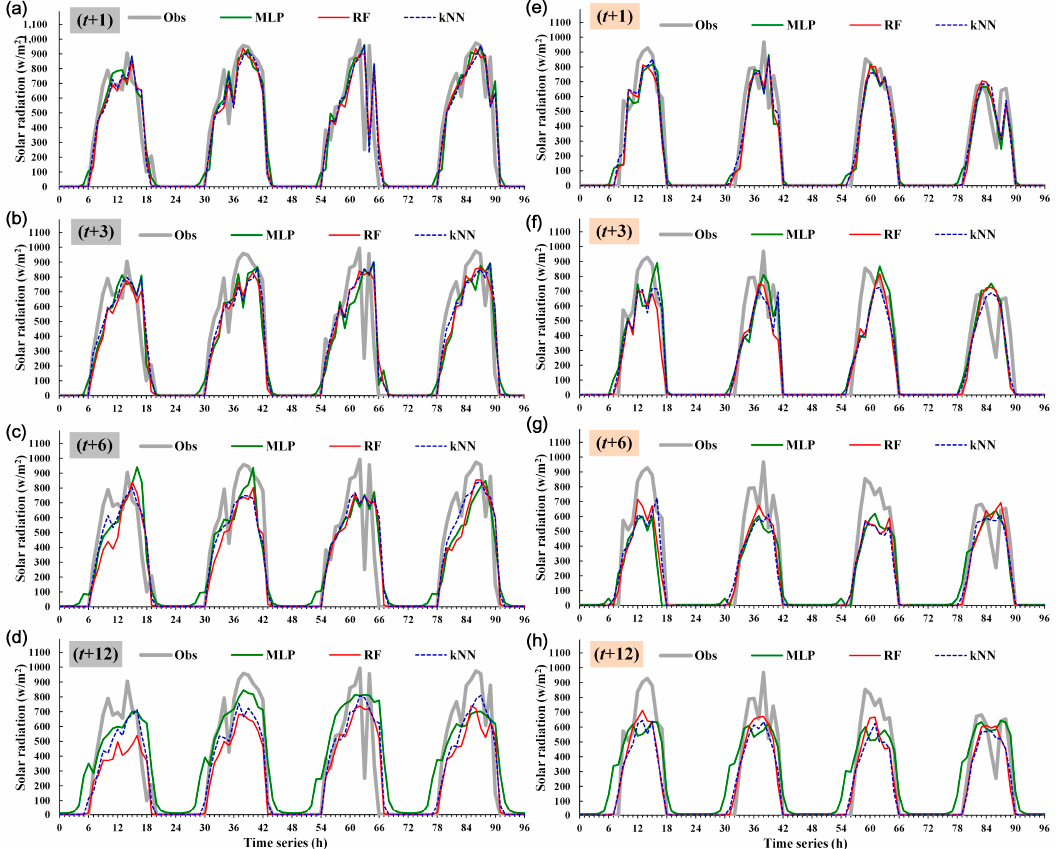
Figure 11. Observed versus predicted changes in the direct irradiance within t + 1, t + 3, t + 6, and t + 12 for 4 consecutive days starting from: ( a – d ) the summer solstice, and ( e – h ) the winter solstice. First, the latitude of Yungkang Weather Station (the study site) was input. Second, parameters related to the solar position (the declination angle, hour angle, and zenith angle; see Section 2.3) were estimated. Third, the observed direct irradiance ( (cid:1835) (cid:3004)(cid:3042)(cid:3029)(cid:3046) ) and the observed diffuse horizontal irradiance ( (cid:1830) (cid:3004)(cid:3042)(cid:3029)(cid:3046) ) were estimated on the basis of the observed global horizontal irradiance ( (cid:1833) (cid:3004)(cid:3042)(cid:3029)(cid:3046) ). Fourth, the predicted direct irradiance ( (cid:1835)(cid:4632) (cid:3004) ) and the predicted diffuse horizontal irradiance ( (cid:1830)(cid:3553) (cid:3004) ) were estimated